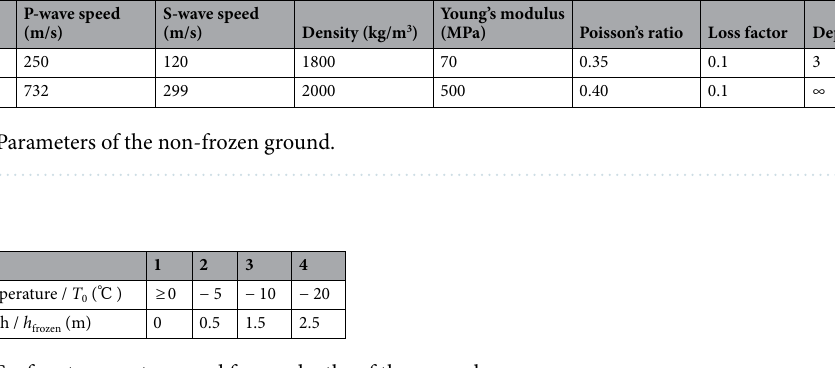
Table 2. Surface temperatures and frozen depths of the